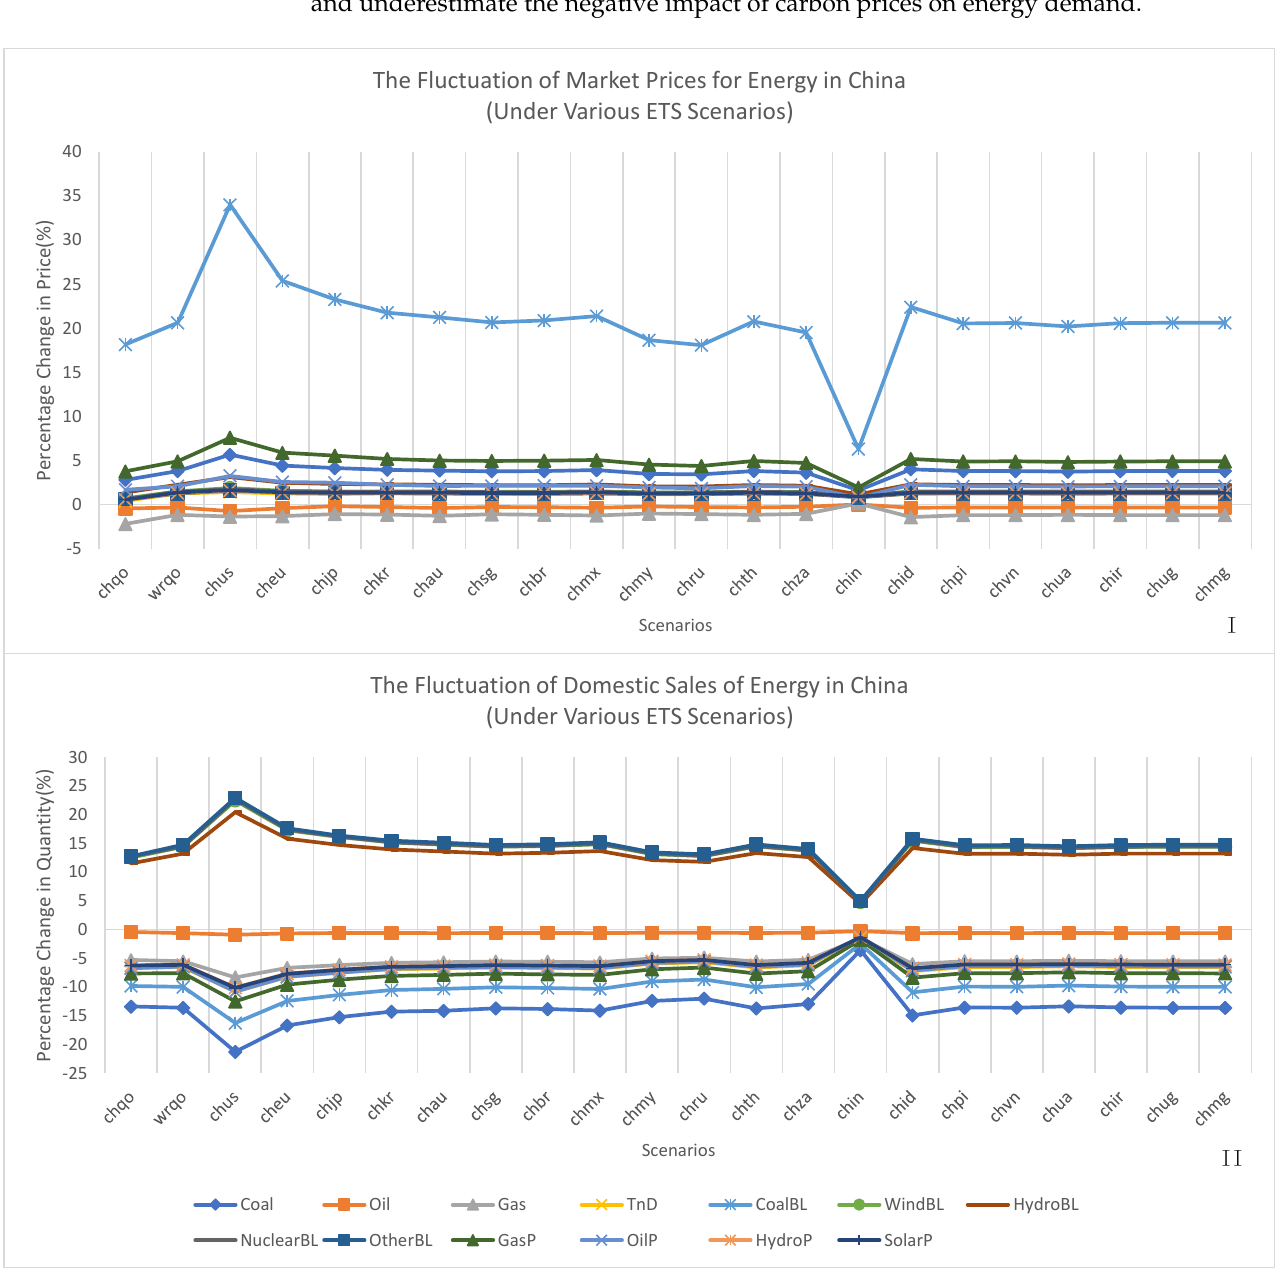
Figure 5. Fluctuations in domestic market prices and energy sales in China. ( I,II ), China’s market price fluctuation under domestic ETS and ETS linking scenarios ( I ), as well as China’s domestic energy sales under domestic ETS and ETS linking scenarios ( II ).